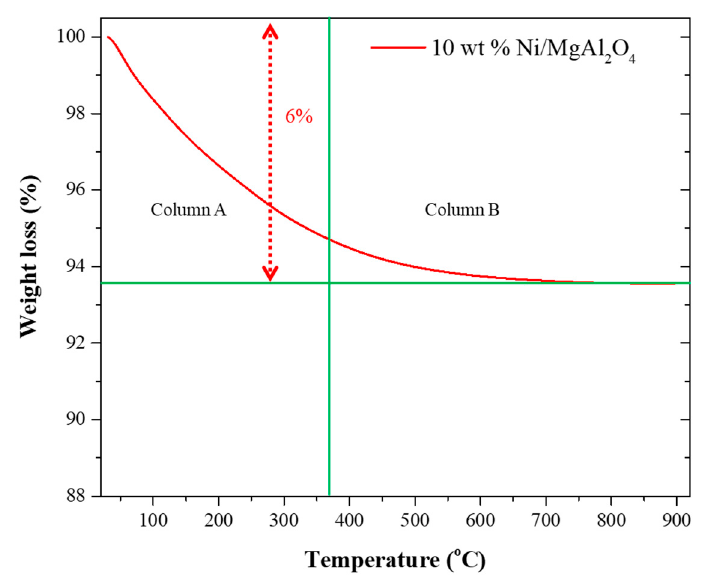
Figure 5. ( a ) EDX elemental analysis of ( a ) MgAl 2 O 4 ( b ) 10 wt% Ni/MgAl 2 O 4 of using point ID technique.